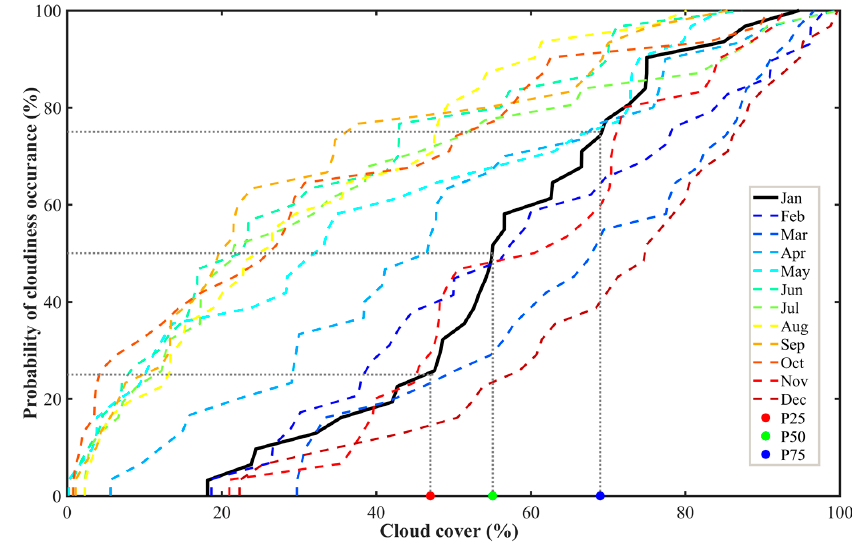
Figure 9. The empirical cumulative distribution function (ECDF) of cloud cover in each month for Terra MOD10A1 in 2004. The red, green, and blue points represent the cloud coverage of the closest images to P25, P50, and P75, respectively. Table 3. The cloud coverage of selected “cloud-free” MODIS SCF images, three extracted mask images, three artificially cloud-filled images, and after the execution of each gap-filling step for the one-day cloud mask.